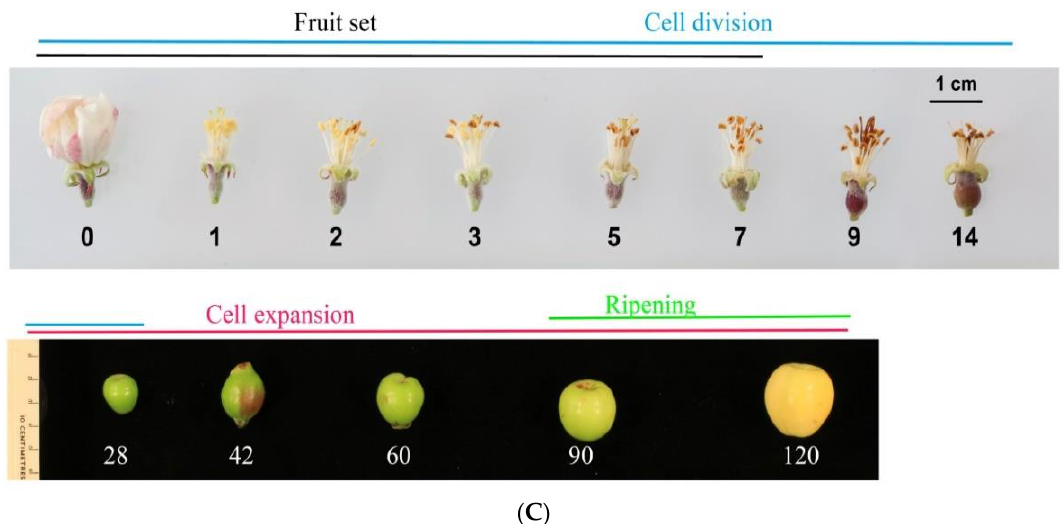
Figure 1. ( A ) The morphology of the “Twenty Ounce” cultivar at various timepoints (DAFB) throughout the developmental stages of fruit set, cell division, cell expansion, and ripening. ( B ) The morphology of the “Royal Gala” cultivar at various timepoints (DAFB) of the fruit development process such as fruit set, cell division, cell expansion, and ripening. ( C ) Crabapple fruit morphology at various timepoints (DAFB) throughout the development stages of fruit set, cell division, cell expansion, and ripening.